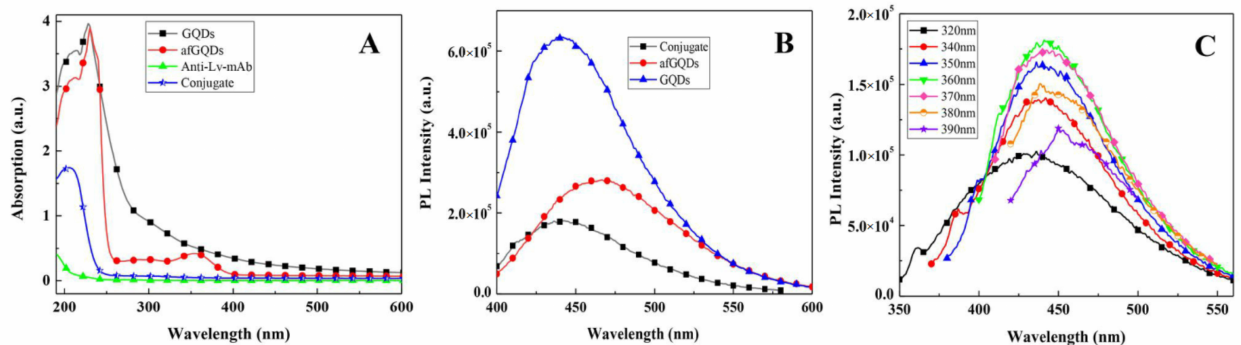
Figure 6. ( A ) UV-Vis absorption spectra of afGQDs, Anti-Lv-mAb and the conjugate of Anti-Lv- mAb/afGQDs; ( B ) PL spectra of afGQDs and Anti-Lv-mAb/afGQDs under excitation at 370 nm; and ( C ) PL spectra of Anti-Lv-mAb/afGQDs under various excitation wavelengths. In ( A , B ), GQDs is used as a